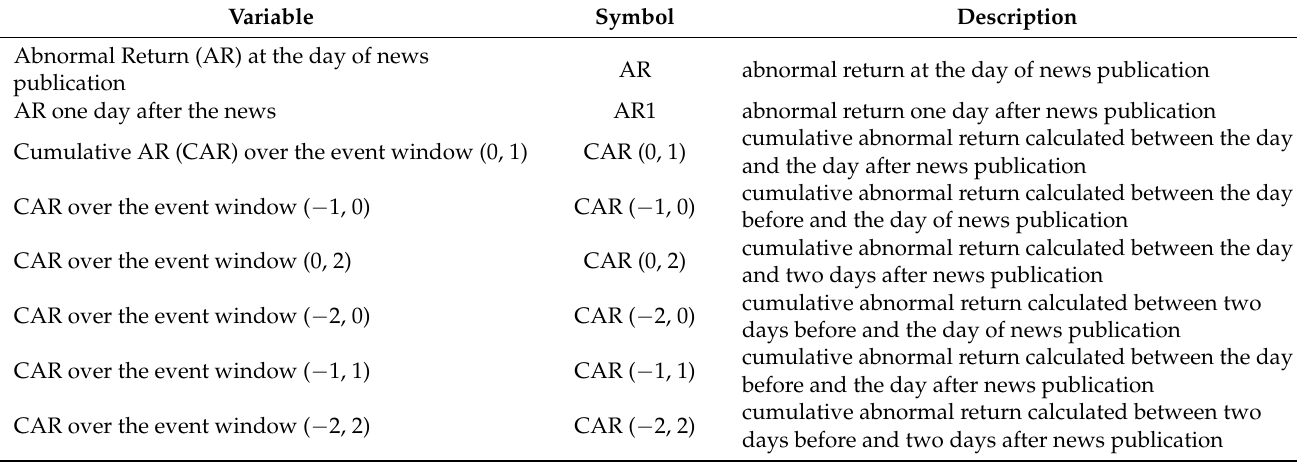
Table 1. Stock market